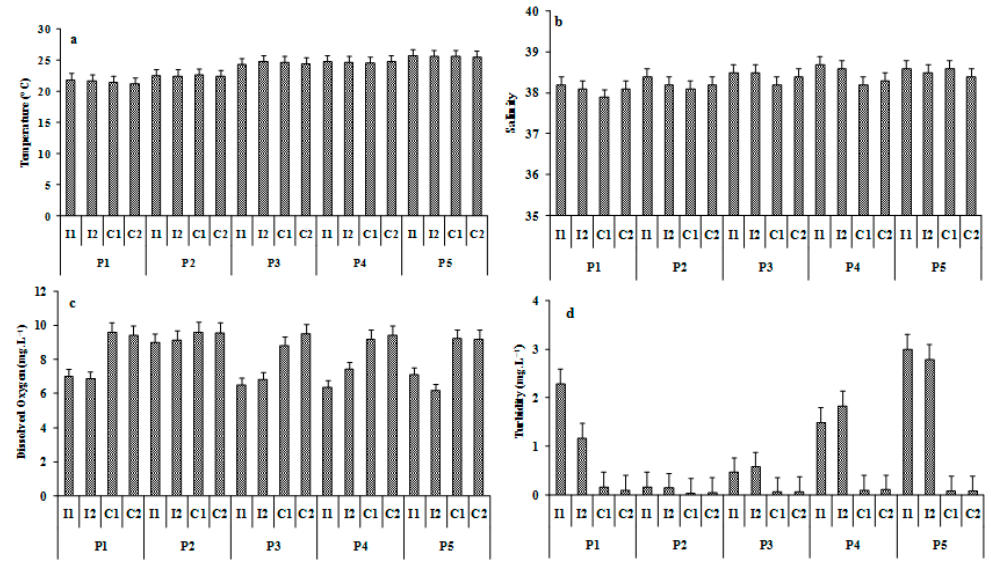
Figure 3. Physicochemical parameters (± SD) during the five sampling periods, with P1: 15 March; P2: 21 April; P3: 6 May; P4: 18 May; and P5: 3 June 2020, were ( a ) temperature (°C), ( b ) salinity, ( c ) dissolved oxygen (mg L − 1 ), and ( d ) turbidity (Suspended solid concentrations; mg L − 1 ).